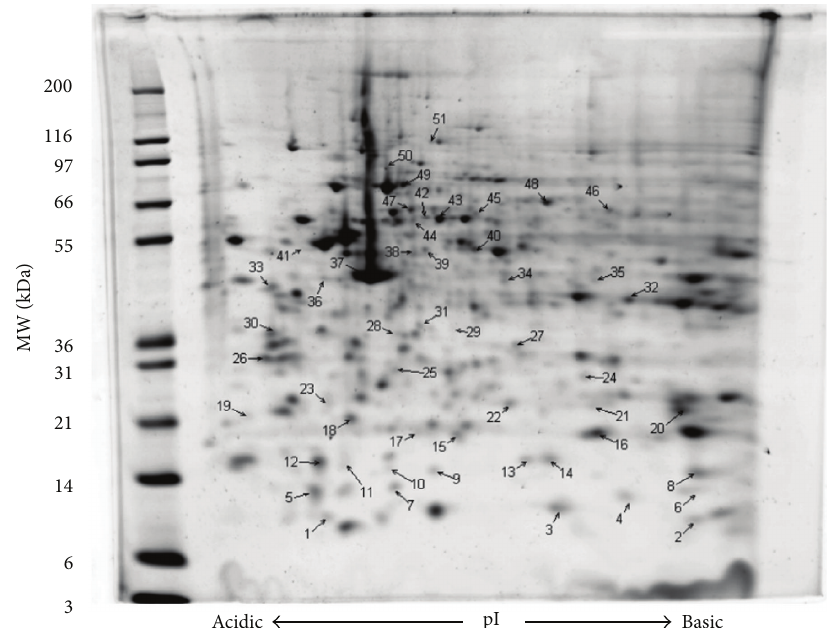
Figure 1: Murine GMC proteome altered by acute (2h) exposure to HG culture conditions. GMC cells were grown to 80% confluence and were serum-starved (0.5% FBS) overnight, and were treated for 2 h with 25 mM glucose (HG) or 5 mM glucose + 20 mM mannitol (NG ∗ ) as an isoosmotic control. Cells were lysed using 2DE buffer and 75 𝜇 g protein used for 2DE analysis. Proteins whose expression is altered by 2 h HG are annotated on the gel with identifications provided in Table 1. Data are representative of five individual gels for HG and for NG ∗